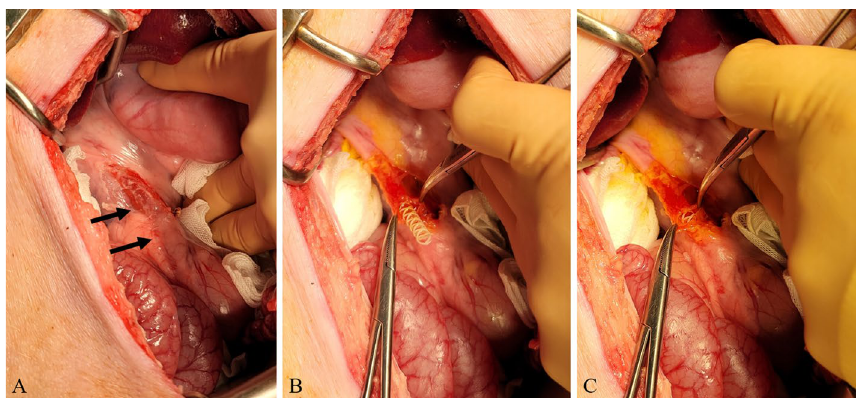
Figure 3. Stent placement in the common bile duct (CBD). ( A ) Identification and exposure of the CBD (arrows). ( B , C ) Transverse incision of the CBD and stent